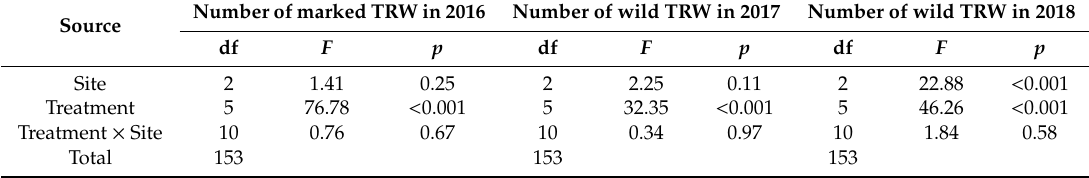
Table 1. E ff ect of treatment [control methods: Trunk trap nets and insecticides applied alone (thiacloprid or cypermethrin spray) and in combination] and site on the number of captured tree-of-heaven root weevils (TRW) in monitoring trunk trap nets